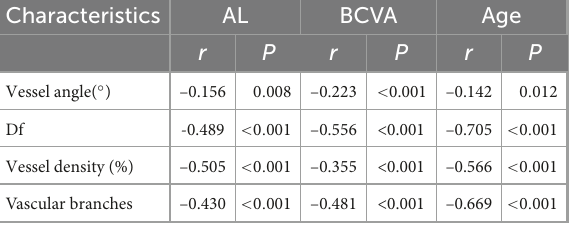
TABLE 3 Correlations of morphological characteristics with AL, BCVA, and age. Characteristics